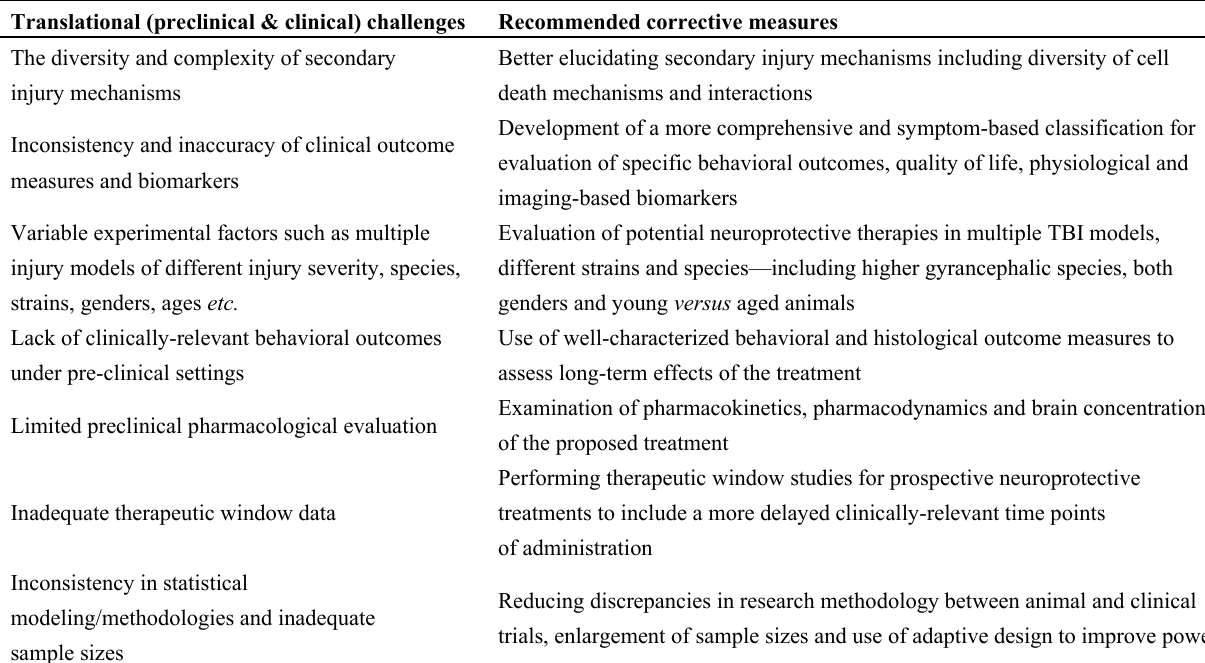
Table 1. Translational challenges and corrective